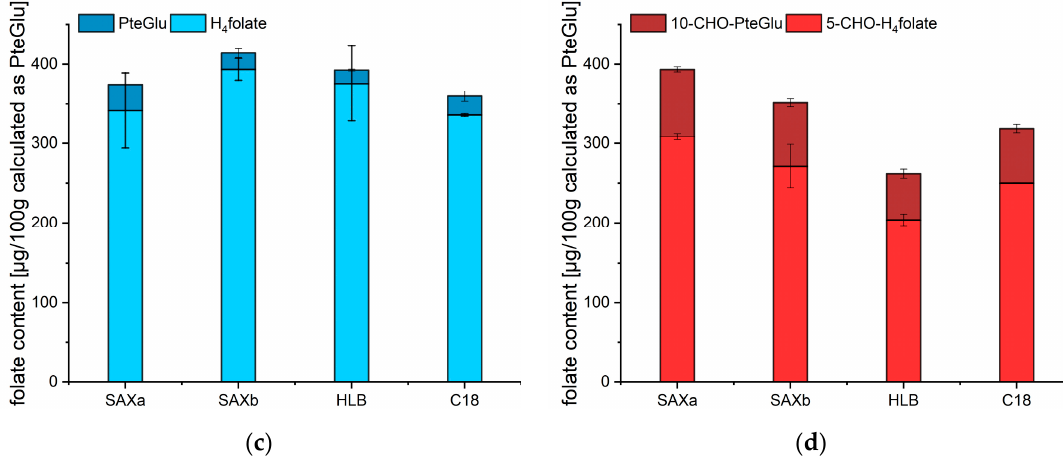
Figure 6. Quantitative analysis of the folate vitamers in baker’s yeast samples purified by different solid phase extraction materials and measured with UHPLC-LC-MS/MS applying stable isotope dilution analysis (SIDA) with purification using SAXa: strong anion exchange (SAX) and elution with elution buffer; SAXb: SAX and elution with 20% acetonitrile and 5% formic acid; HLB: hydrophilic–lipophilic-balanced; C18. ( a ) Total folate analysis for different vitamers, ( b ) total folate analysis for 5-CH 3 -H 4 folate and MeFox, ( c ) total folate analysis for H 4 folate and PteGlu and ( d ) total folate analysis for 5-CHO-H 4 folate and 10-CHO-PteGlu.